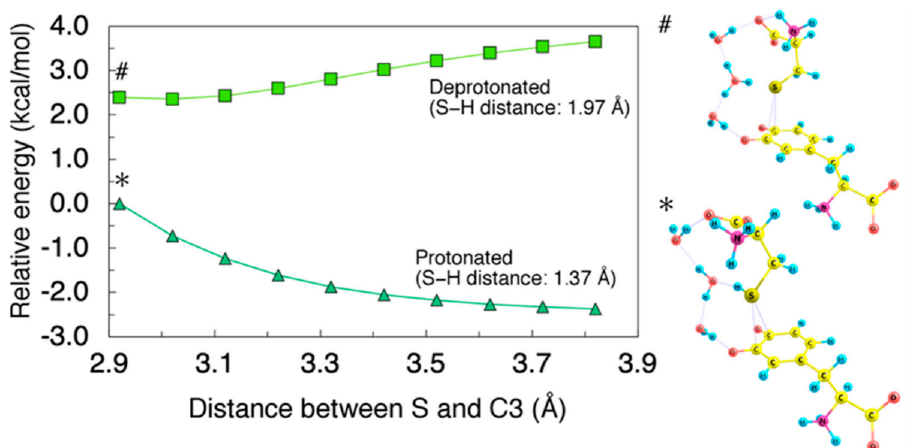
Figure 3. ( Left ) Minimum energy path for Cys–S − (S–H distance: 1.97 Å) and Cys–SH (S–H distance: 1.37 Å) coordination on C3 − C4 bridge plotted as squares and triangles, respectively. H 2 O trimer was used as an acceptor for dissociating proton. Energies were ref- erenced to the total energy of the protonated Cys–SH-DQ complex with 2.92 Å of C3 − S dis- tance. All geometrical parameters except for the C3 − S and S − H distance were allowed to relax. ( Right ) Cys–S − - (#) and Cys–SH- (*) coordinated structure.